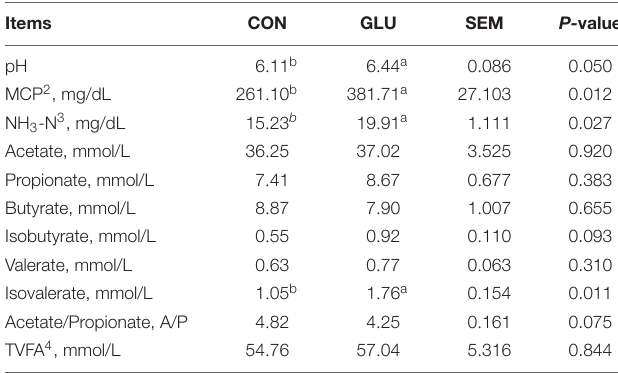
TABLE 6 | Effects of glutamate supplementation on rumen fermentation characteristics of heat-stressed Hu sheep ( n = 6) 1 . Items CON GLU SEM P-